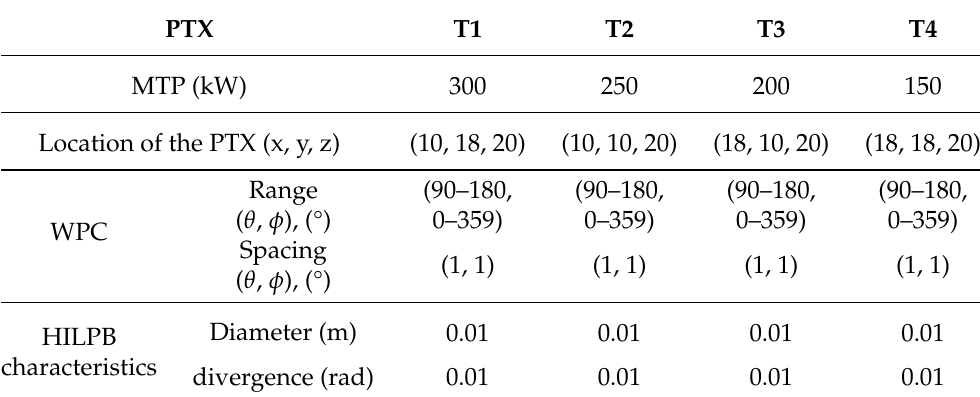
Table 4. Characteristics of the PTXs used in the simulation.